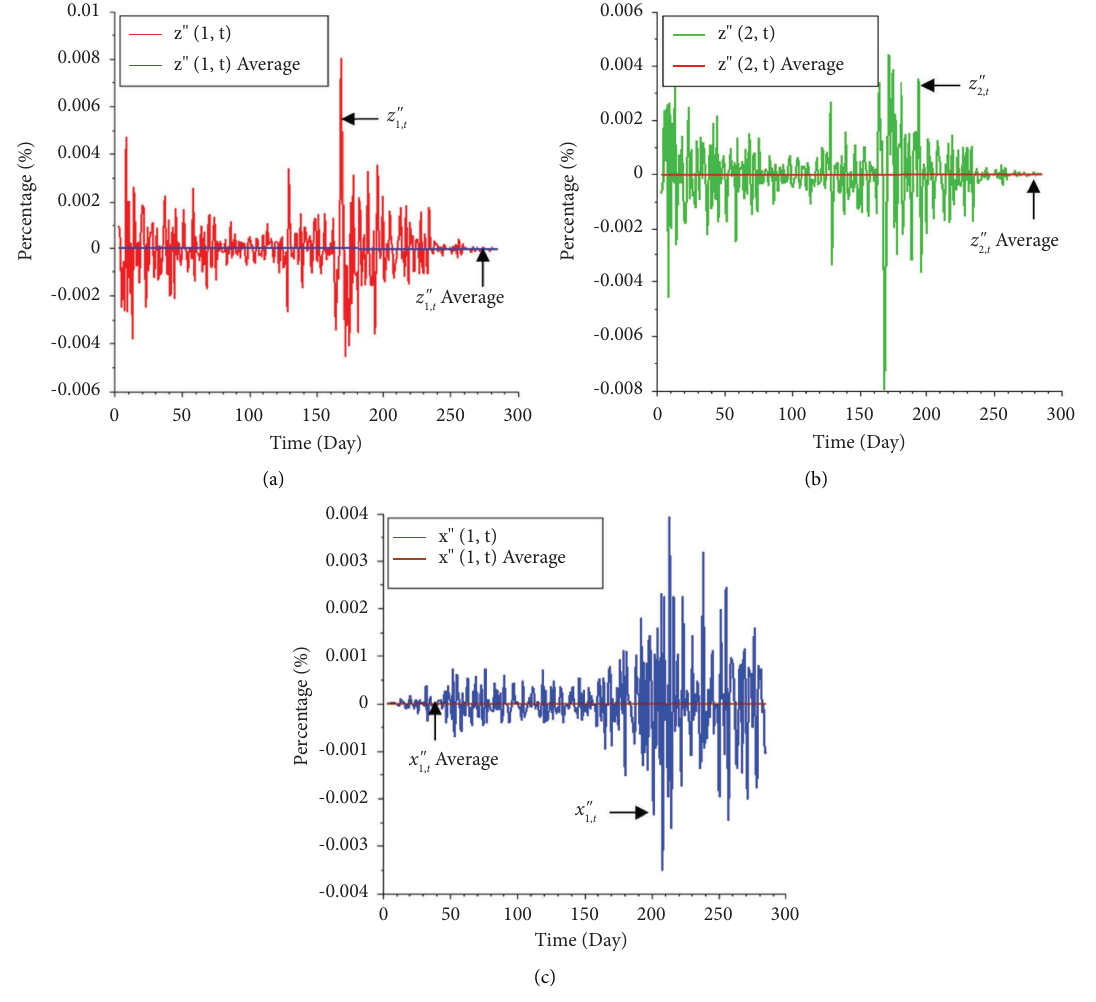
Figure 2: Graph of z ″ , z ″ , and x 1 ,t 2 ,t